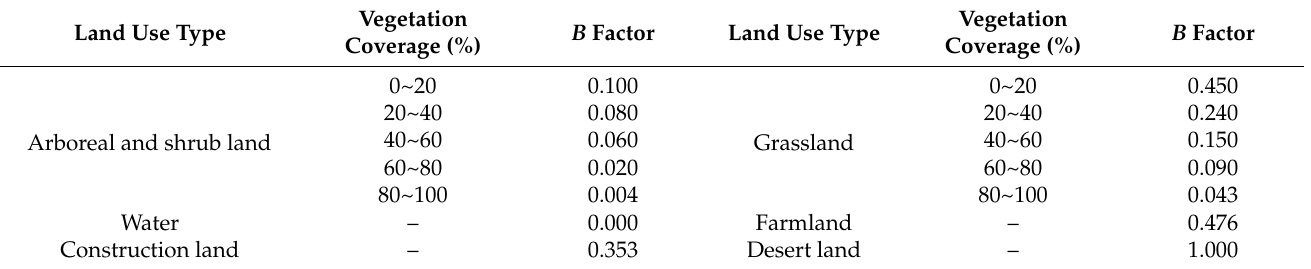
Table 1. B factor under different land use types and different vegetation